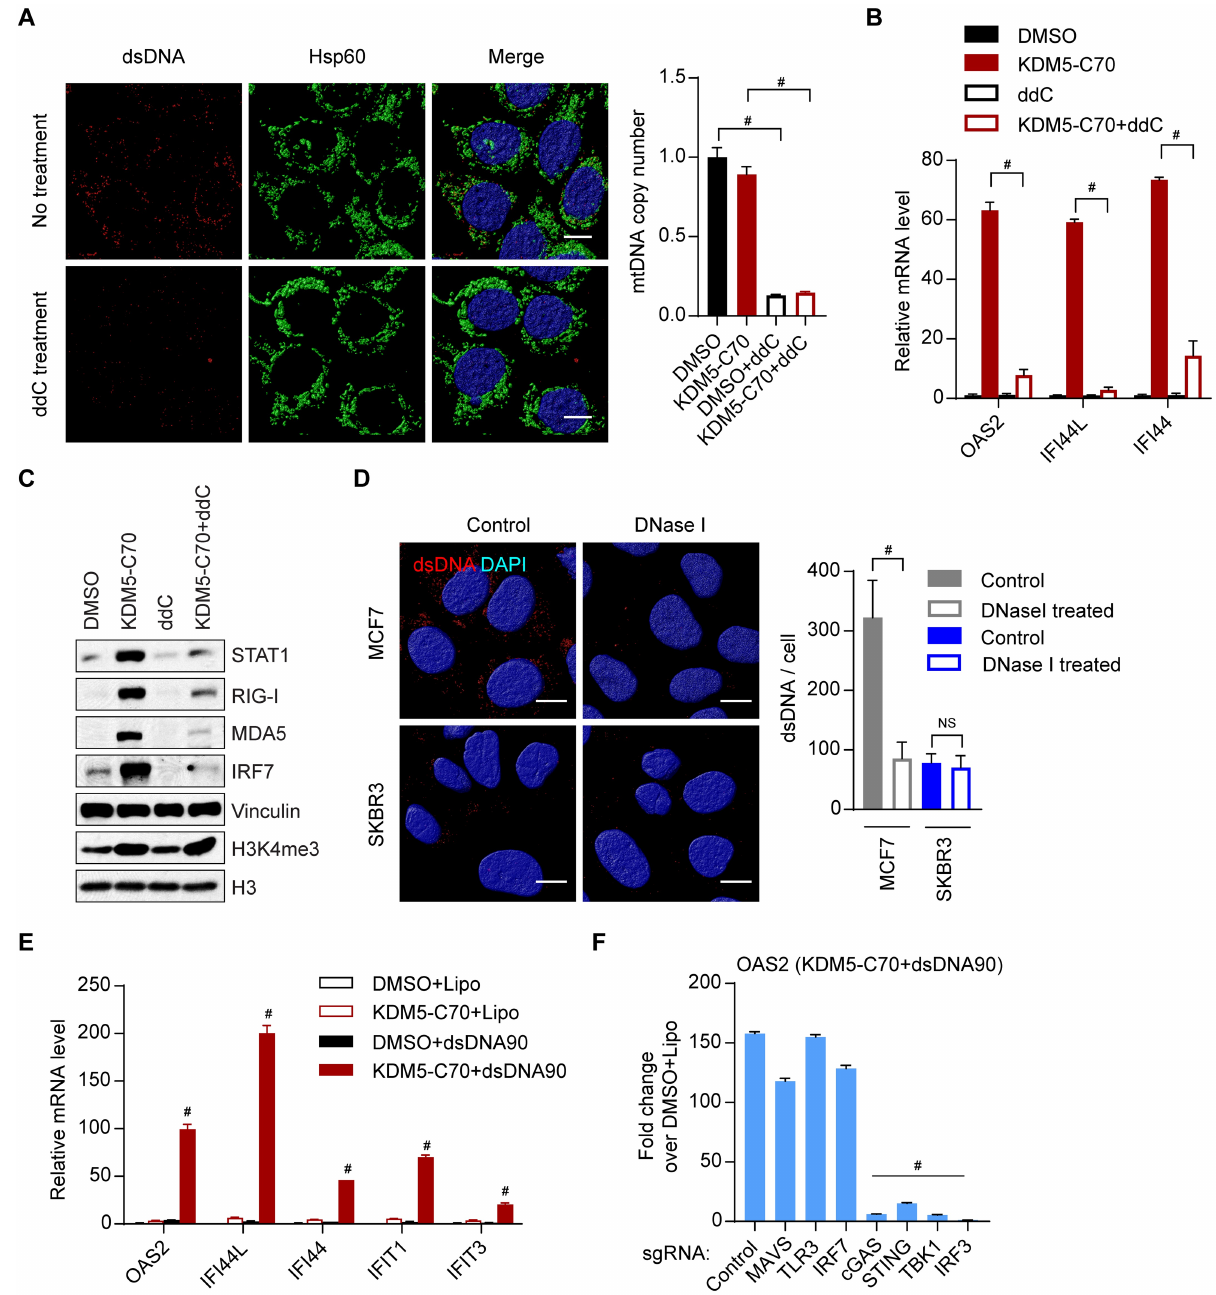
Fig 6. KDM5 inhibition induces a robust interferon response in cancer cells with elevated levels of cytosolic DNA. (A) Immunostaining of dsDNA and the mitochondrial marker Hsp60 in MCF7 cells. Surface plots of Z-stack images generated with Huygens (left panel). qPCR detecting mtDNA copy number in cells with the indicated treatment (right panel). 10 μM of ddC was used. Scale bar, 10 μm. (B, C) RT-qPCR (panel B) and western blot (panel C) analyses of MCF7 cells with the indicated treatment. MCF7 cells were treated with 10 μM ddC and 1 μM KDM5-C70 for 6 days. Cells were refed every 2 days. (D) dsDNA and DAPI staining of MCF7 cells or SKBR3 cells digested with 50 μg/ml DNase I. Surface plots of Z-stack images generated with Huygens (left panel). Quantification of dsDNA intensity per cell using image J was shown in the right panel. Scale bar, 10 μm. (E) RT-qPCR analyses of SKBR3 cells with the indicated treatment. SKBR3 cells were transfected with 1 μg dsDNA of about 90 bp (dsDNA90) using Lipofectamine 2000 5 hours before treatment with DMSO or 1 μM KDM5-C70 for 3 days. (F) RT-qPCR analysis of SKBR3 cells with knockout of the indicated genes after treatment with 1 μg dsDNA and 1 μM KDM5-C70 for 3 days. Representative data from triplicate experiments are shown. Error bar denotes SEM. # p < 0.01 for panel A, B, and D–F, for KDM5-C70 + dsDNA90 versus DMSO + lipo (panel E), and for knockout sgRNA versus control sgRNA (panel F). The numerical values used to generate graphs in panel A, B, and D–F are available in S1 Data. ddc, dideoxycytidine; dsDNA, double-stranded DNA;